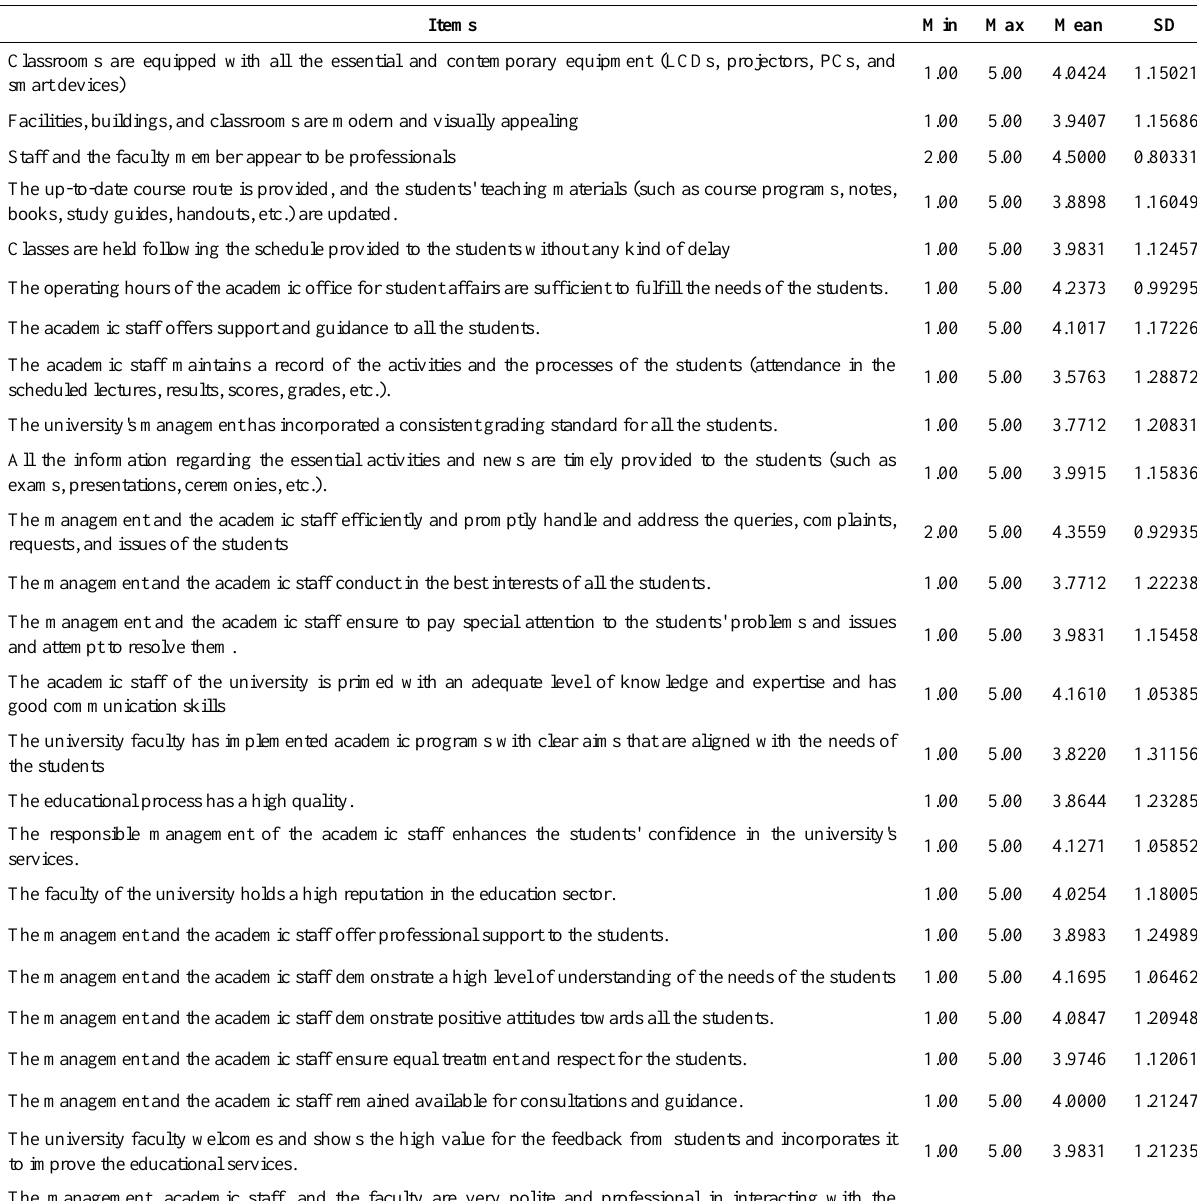
Table 4. Descriptive statistics for service quality expectations of the students in Indonesia Items Min Max Mean